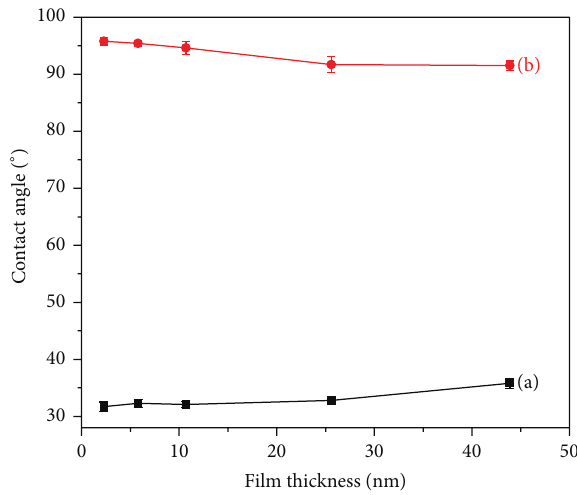
Figure 5: The contact angles of PEO- b -PS films with different initial thickness (a) before and (b) after annealing at 393 K for